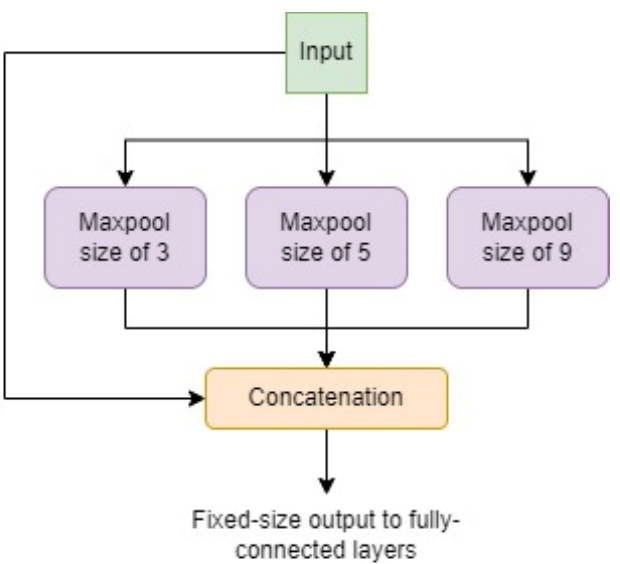
Figure 7. A graphical representation of the SPP block in the neck of the proposed NextDet object detector.